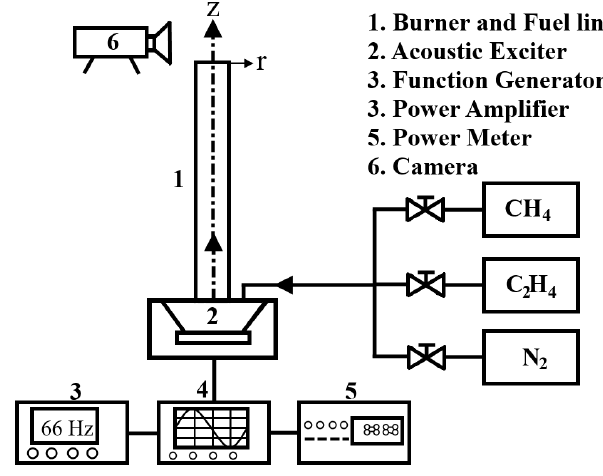
Figure 1. Schematic of acoustically modulated jet flow system.